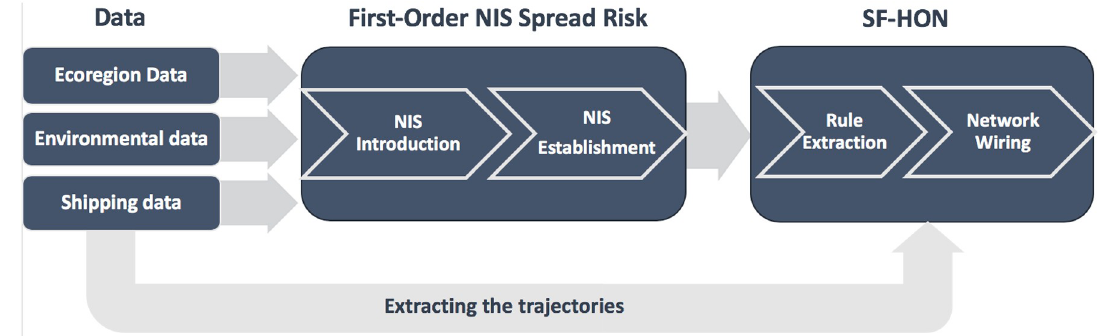
Fig 2. A block diagram of the risk network construction. The ecoregion data, environmental data, and the shipping data are used to compute the first-order (pairwise) NIS spread link between the shipping ports through each shipping introduction vector. The resulting probabilities along with the shipping trajectories are used for constructing the two SF-HONs, ballast SF-HON and biofouling SF-HON.